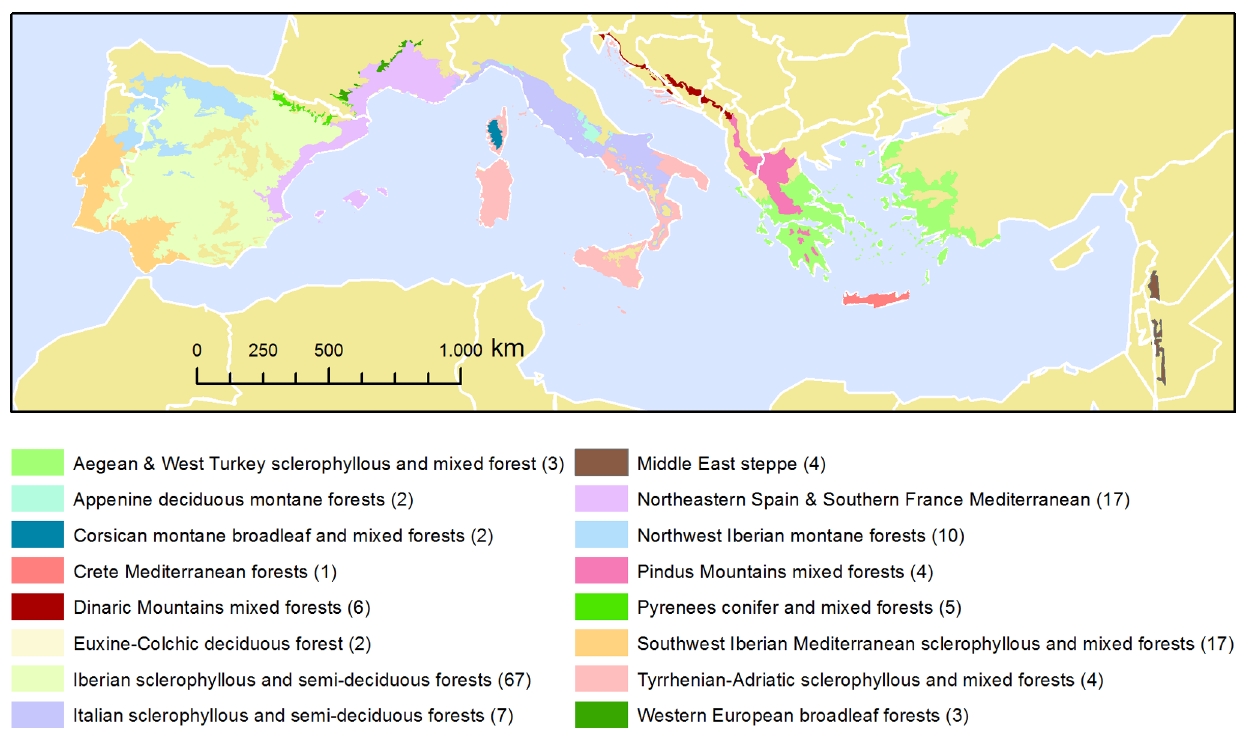
Figure 2. Map of ecological regions included in the analysis. Numbers in brackets specify the number of cases considered per ecological region.